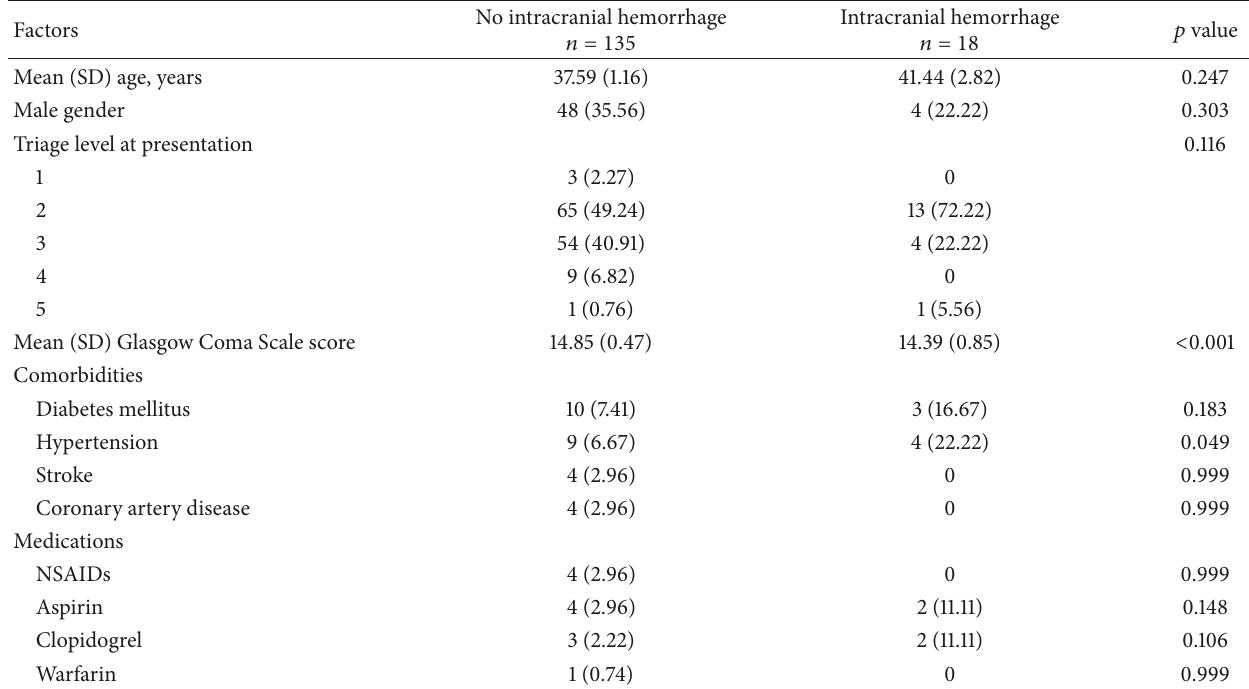
Table 1: Baseline characteristics of head injury patients who were at moderate risk for intracranial hemorrhage categorized by evidence of intracranial hemorrhage from computed tomography of the